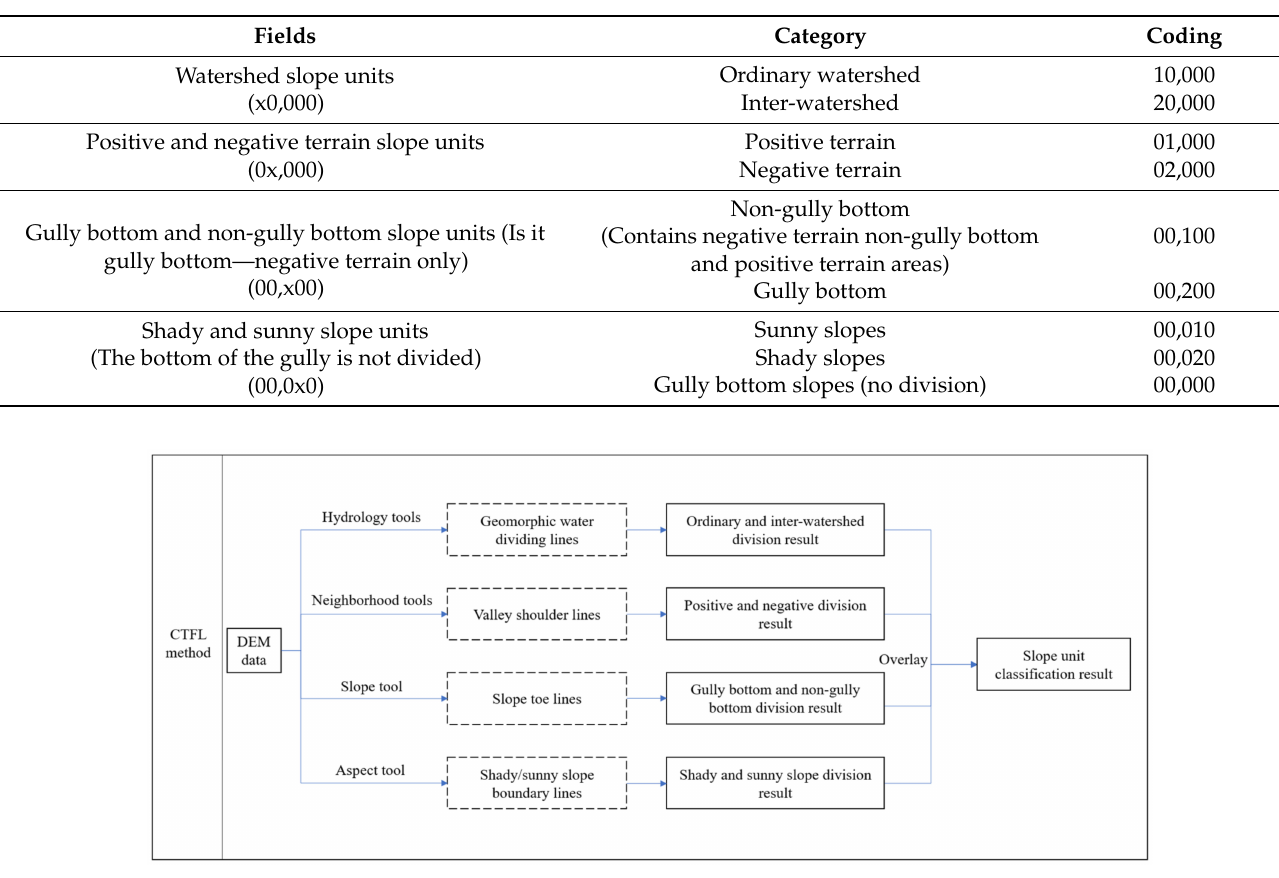
Figure 2. The general flowchart of CTFL method (see Figures 4, 6, and 8 for detailed